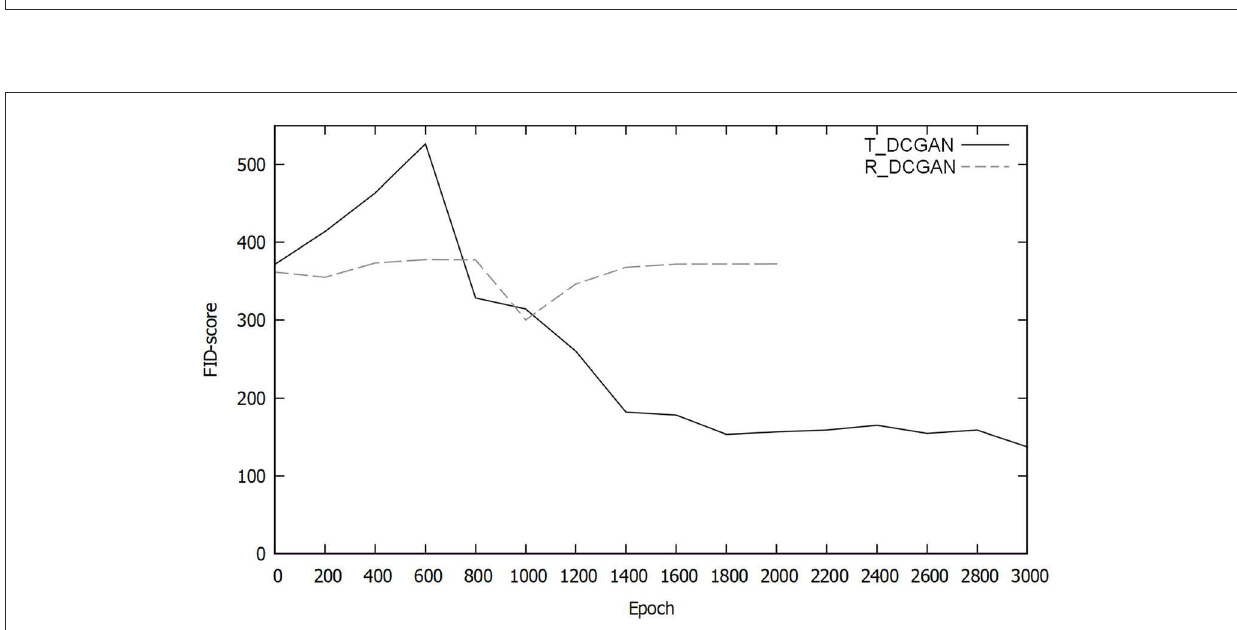
FIGURE9 Comparison of the FID scores of T_DCGAN and R_DCGAN variants of DCGAN over time (the lower the FID score is, the better the